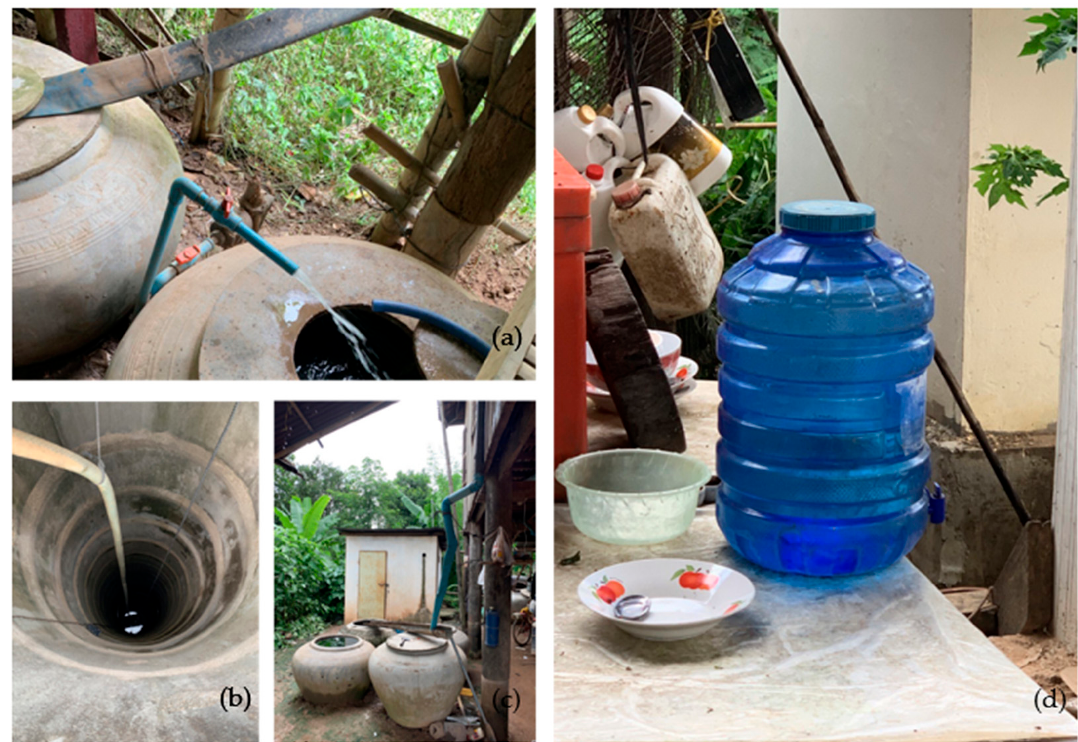
Figure A3. ( a-1 to a-3 ) Distribution pipe installation; ( b-1 and b-2 ) water purification installation; ( c- 1 and c-2 ) water meter installation; and ( d ) water pressure meter.